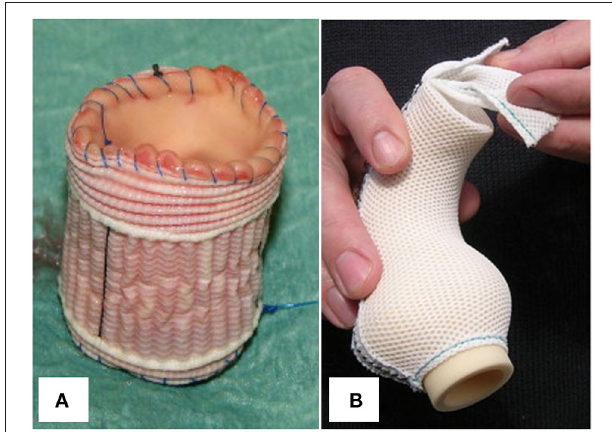
FIGURE 8 | (A) Pulmonary autograft wrapped with a cylinder of microporous Dacron graft. (B) Personalized external aortic root support implant fashioned from porous, soft mesh. Figure adapted with permission from Carrel et al. (34) and Treasure et al.